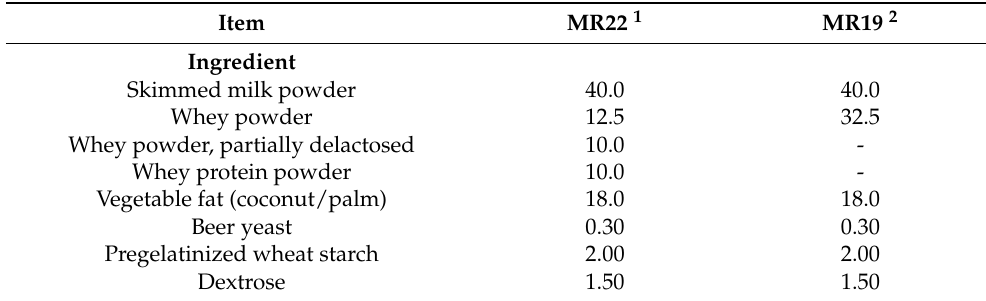
Table 1. List of ingredients, energy content and chemical composition as analyzed (% of DM unless stated) of milk replacers (MR) containing two different levels of